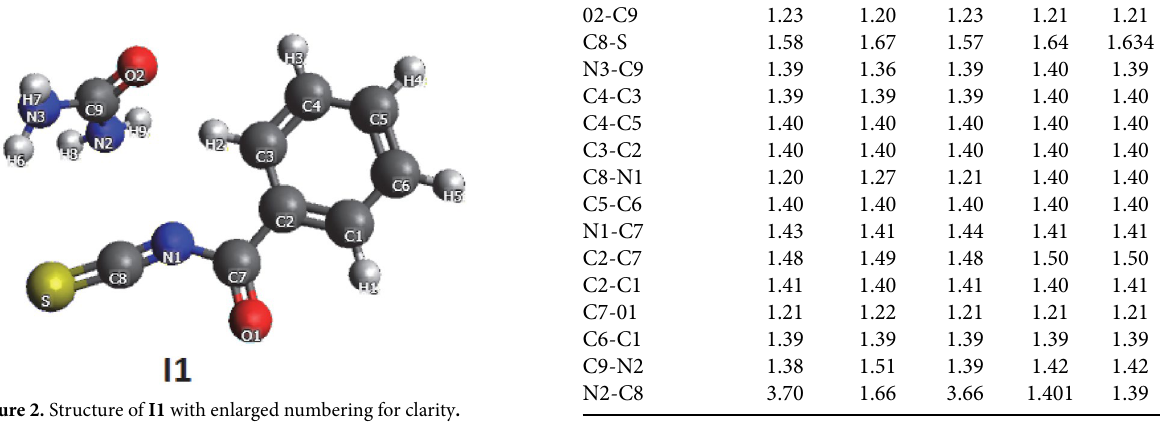
Table 1. Comparison of the bond lengths of the starting species, intermediates, transition states and products. Bond length/Å